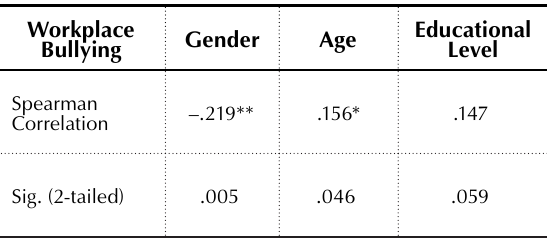
Table 4. Correlation between workplace bullying and demographic data for respondents